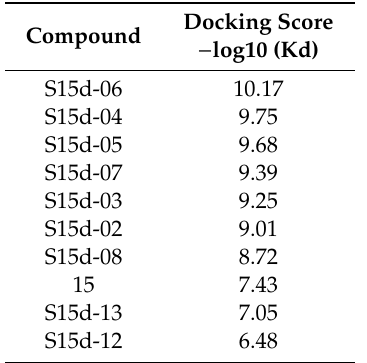
Table 3. HDAC4 Docking scores of cyclopropane derivatives compounds designed to have electrostatic interactions with Asp-759 residue on rim of